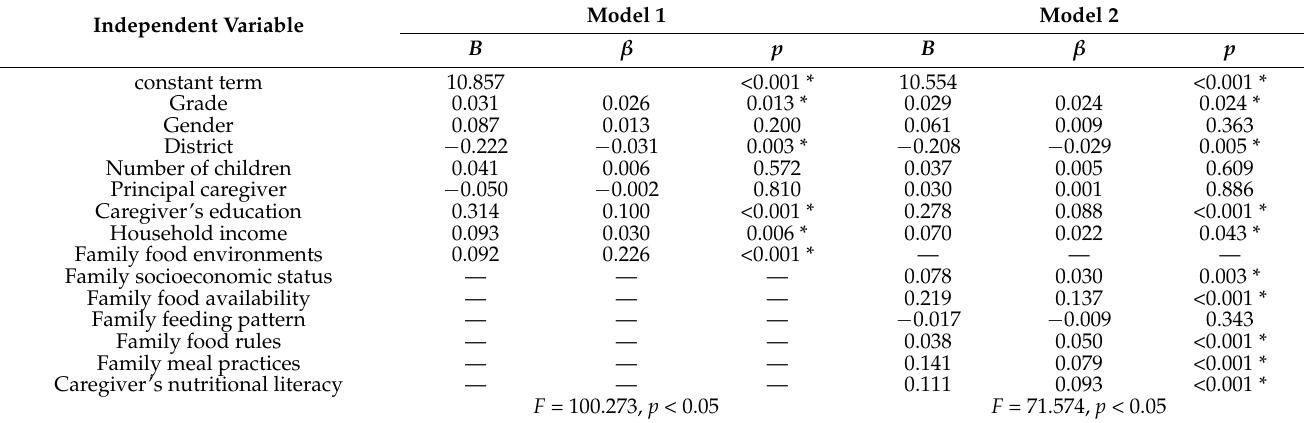
Table 6. Multiple linear regression analysis of overall food consumption score.